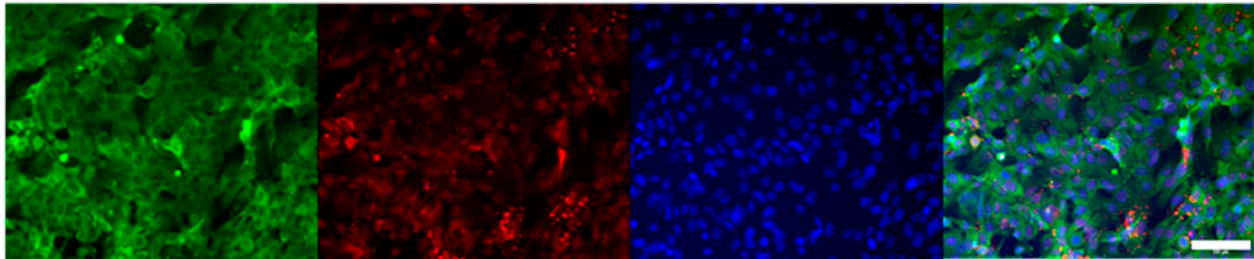
Sensors 2021 , 21 , x FOR PEER REVIEW Figure 4. Confocal images of a cross-section of top and bottom channels. The diagram ( A ) indicates the area of a cross-section where the image was taken. Z-projection of the membrane position with endothelial cells and pericytes on opposite sides of the membrane ( B ), and bottom position with endothelial cells ( C ). 3D view of the cross-section ( D ). ZO-1 tight junctions are stained in green. VE-cadherin adherens junctions are stained in red. Nuclei are stained in blue. Scale bars are 100 µm. The white dashed line in confocal images indicates the shadow coming from the wall of the channels.